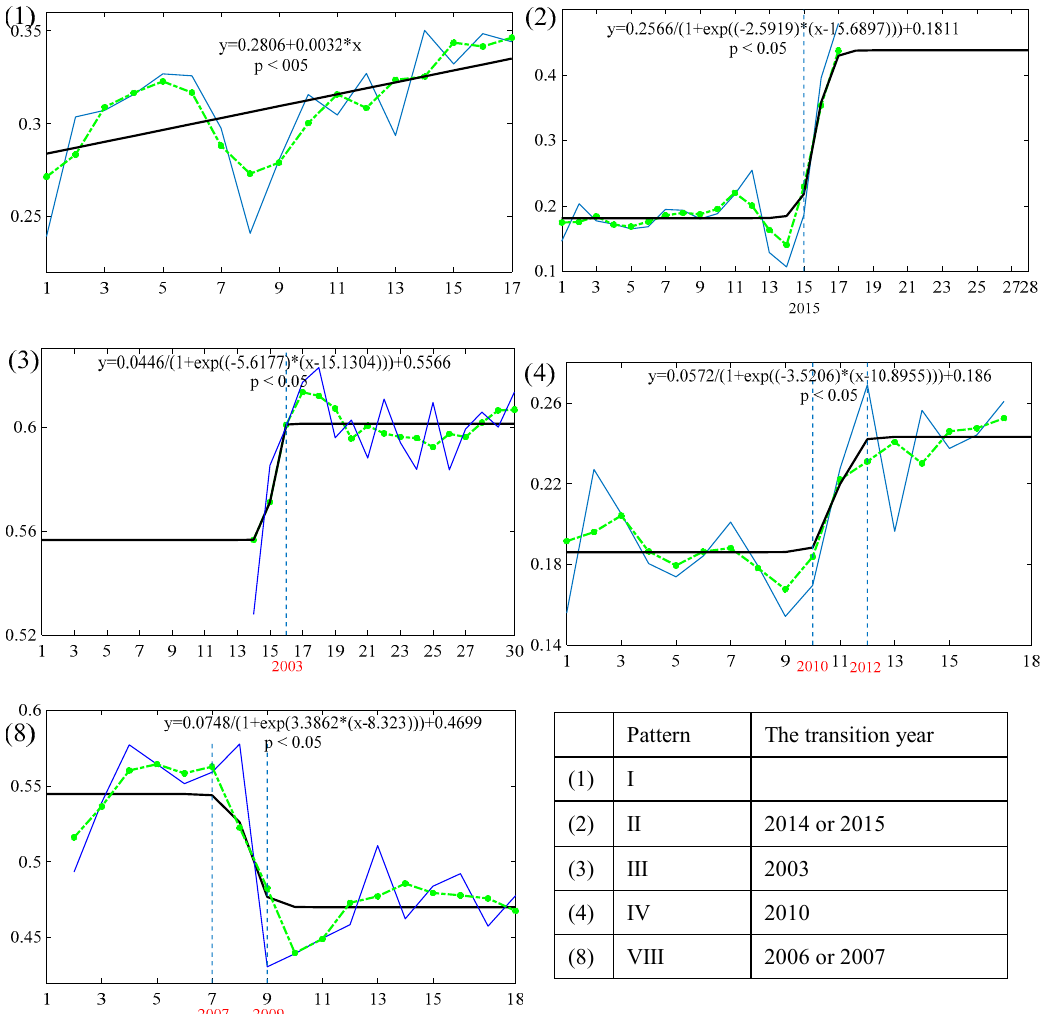
Figure 9. The temporal trajectories of the five regions selected for validation. The number of each subfigure corresponds to the number of the validated region in Figure 3 and Figure 4. The pattern and the transition years of each region detected by our framework are obtained from Figure 3 and Figure 4, respectively and are listed in the table on the low right of the figure. The values in the vertical axis of each subgraph are the mean NDVI of all the pixels which had the same transition years as that listed in the table on the low right corner.